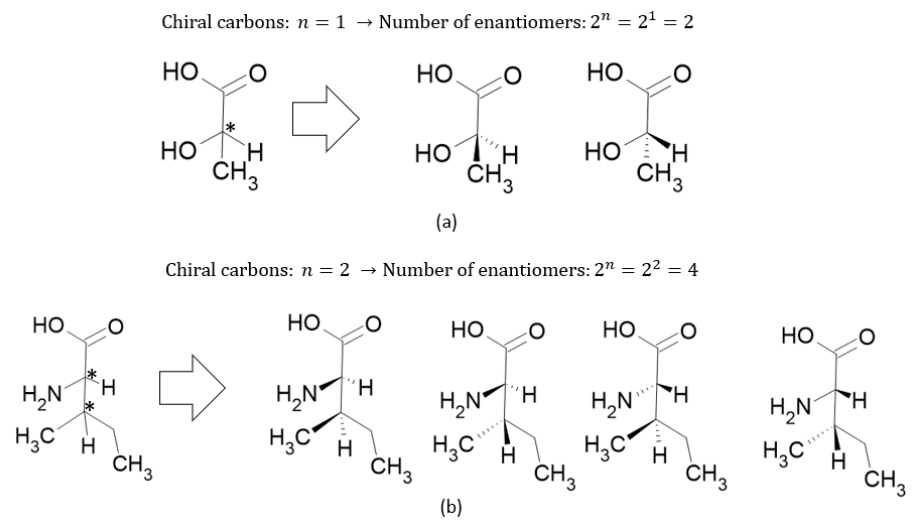
Figure 3. Number of enantiomers related to the numbers of chiral carbons (*) for ( a ) lactic acid and ( b ) isoleucine.